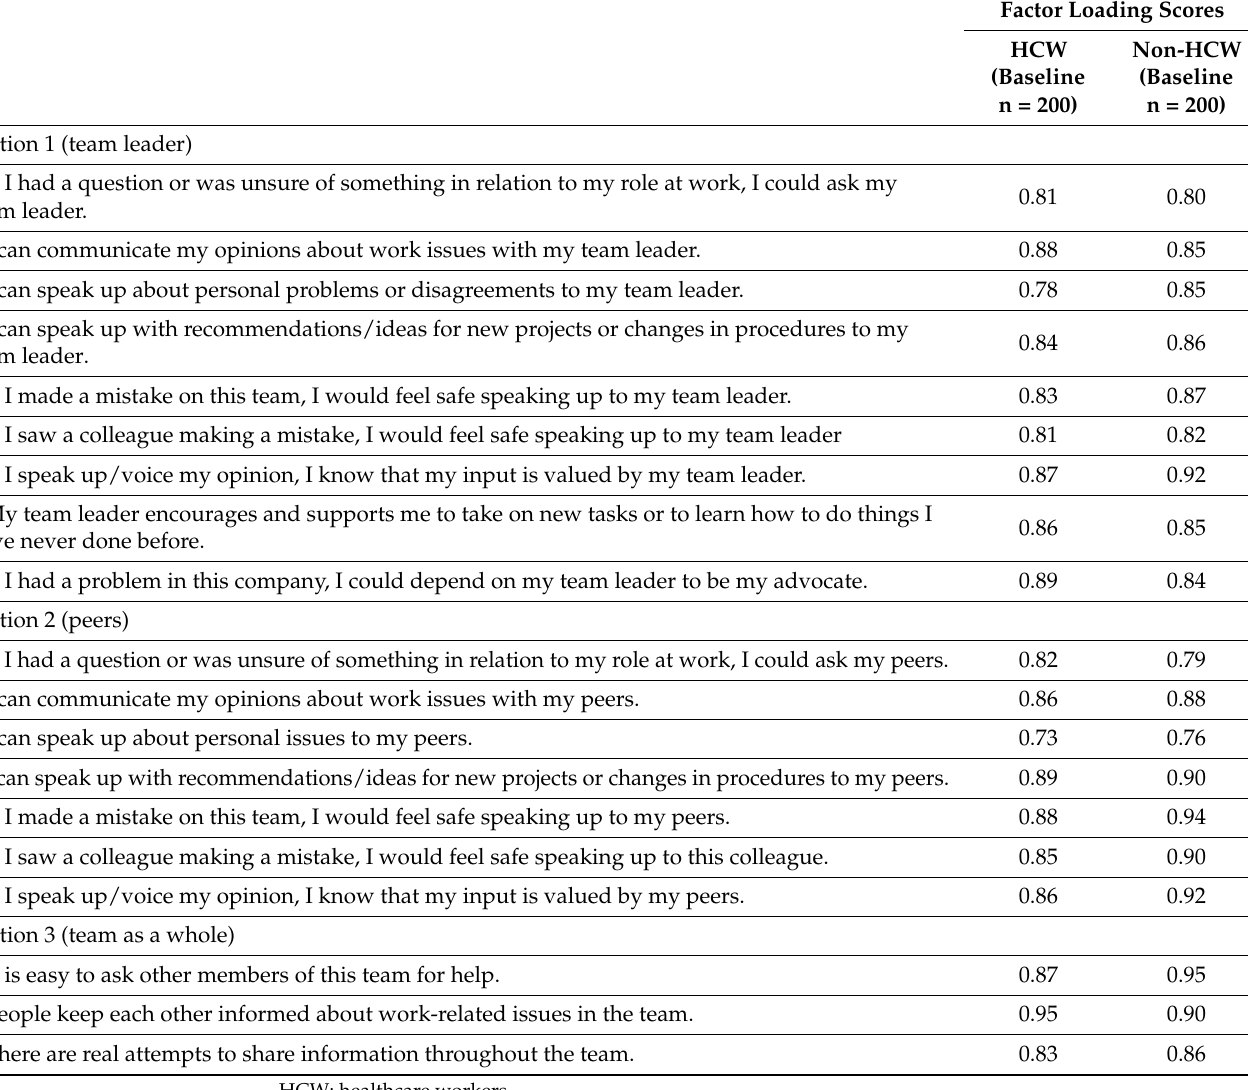
Table 3. Factor loading scores from the confirmatory factor analysis based on three-factor